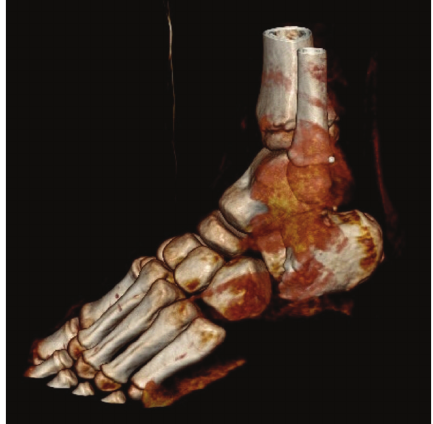
Figure 3: CT 3D reconstruction of left ankle displaying fracture and dislocation through calcaneal body.